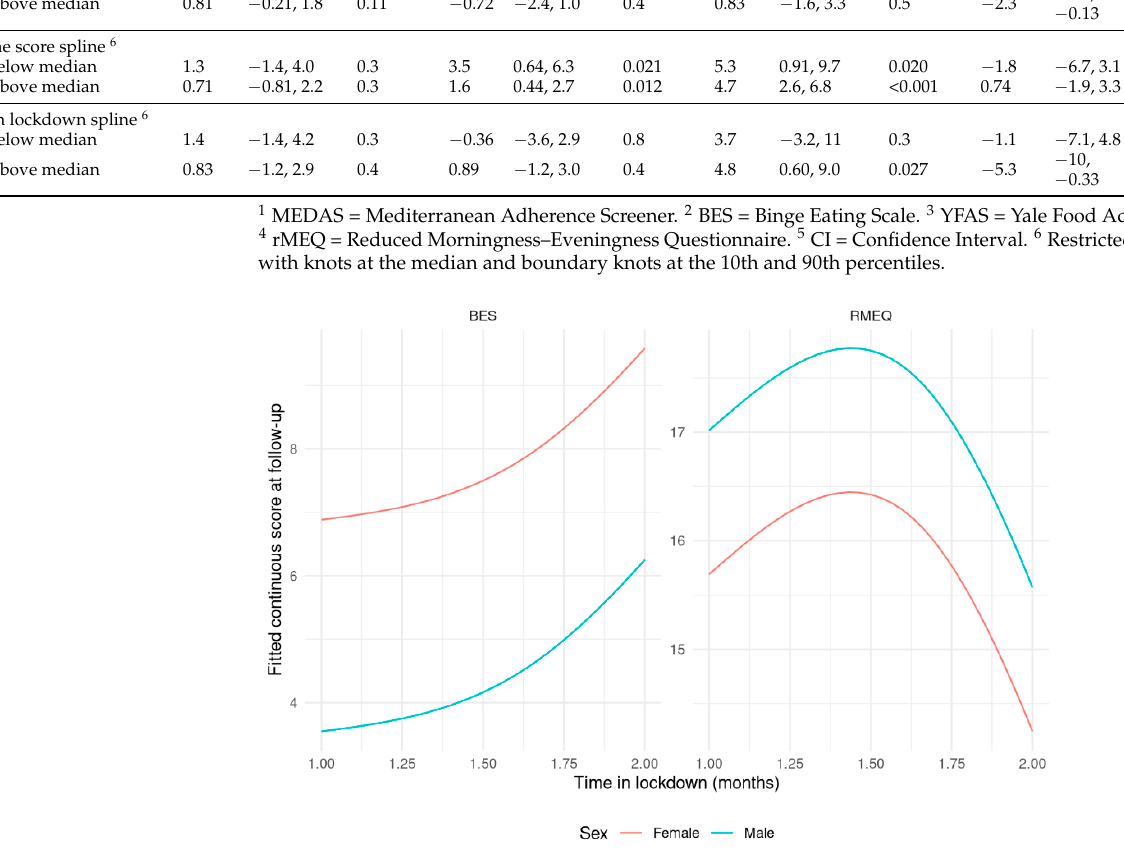
Figure 2. Partial effects of questionnaire scores at follow-up against time in lockdown. The left panel shows Binge Eating Scale score and the right panel shows the short Morningness–Eveningness Questionnaire score.